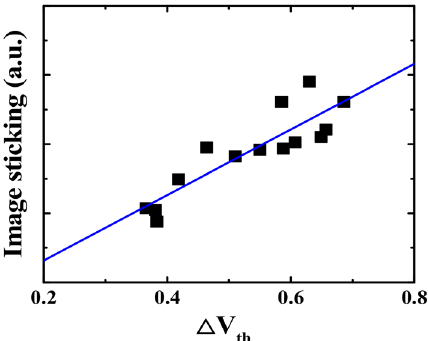
Figure 3. Correlation between PI charging induced V th shift and image sticking for an LTPS TFT with a PI substrate.